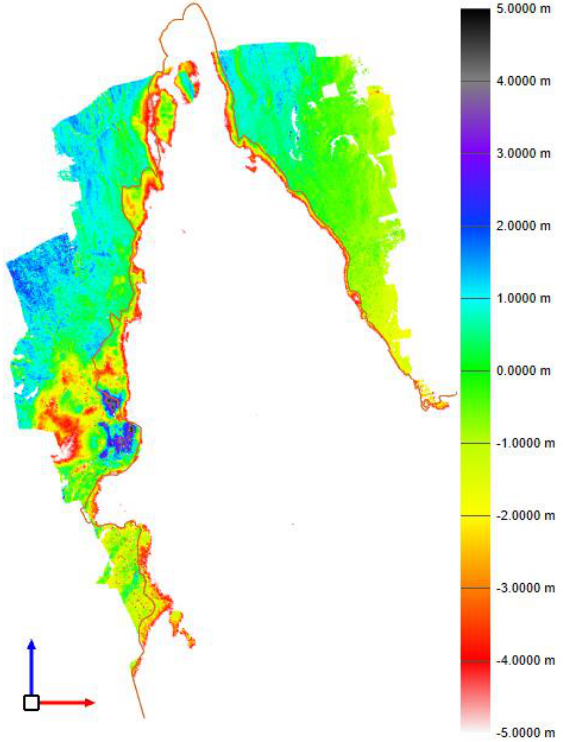
Figure 6. Height comparison map between 2014 DPC co- registered using CP2016 method and 2016 DPC: focus on the area outside the glacier.